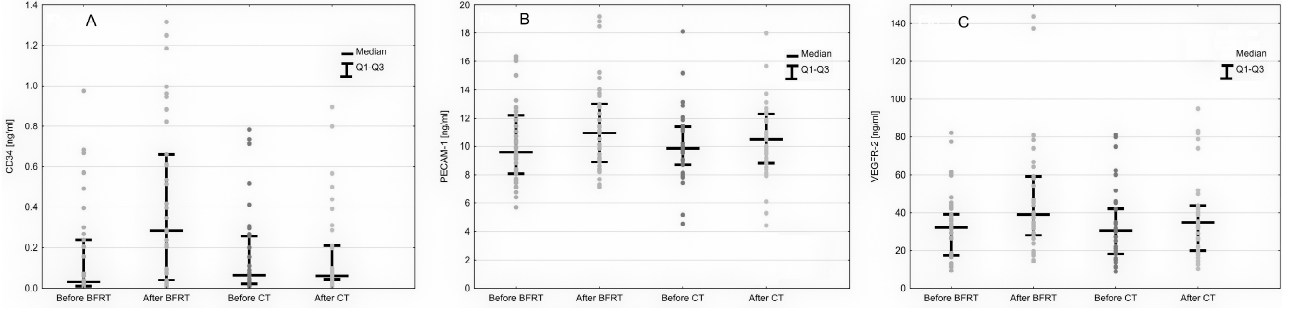
Figure 3. Changes in CD34 ( A ), PECAM1 ( B ) and VEGFR-2 ( C ) compared between participants after BFR exercise and control